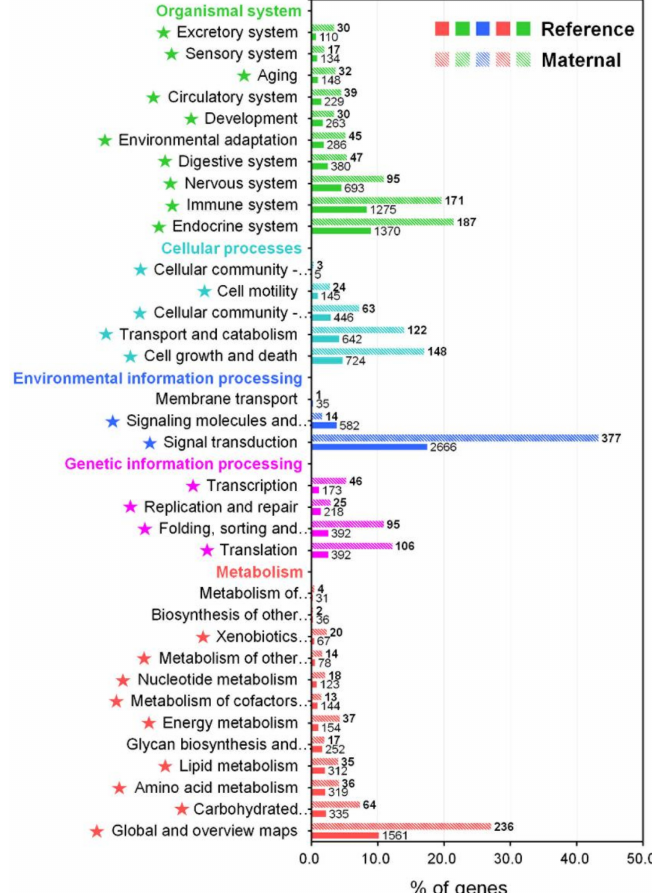
Figure 3. KEGG pathway annotation for the reference transcriptome and enrichment analysis of maternal gene transcripts using the Pearson Chi-Square test. Star marks in front of pathways indicate significantly enriched KEGG pathway ( p <